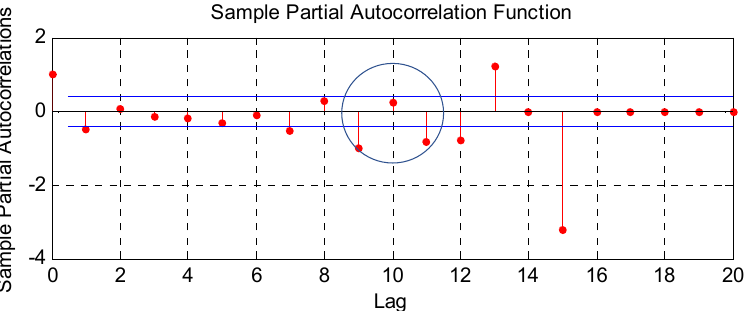
Figure 13. Partial autocorrelation function of time series composed of 1 and − 1 values for first difference displacements (M4 x ).